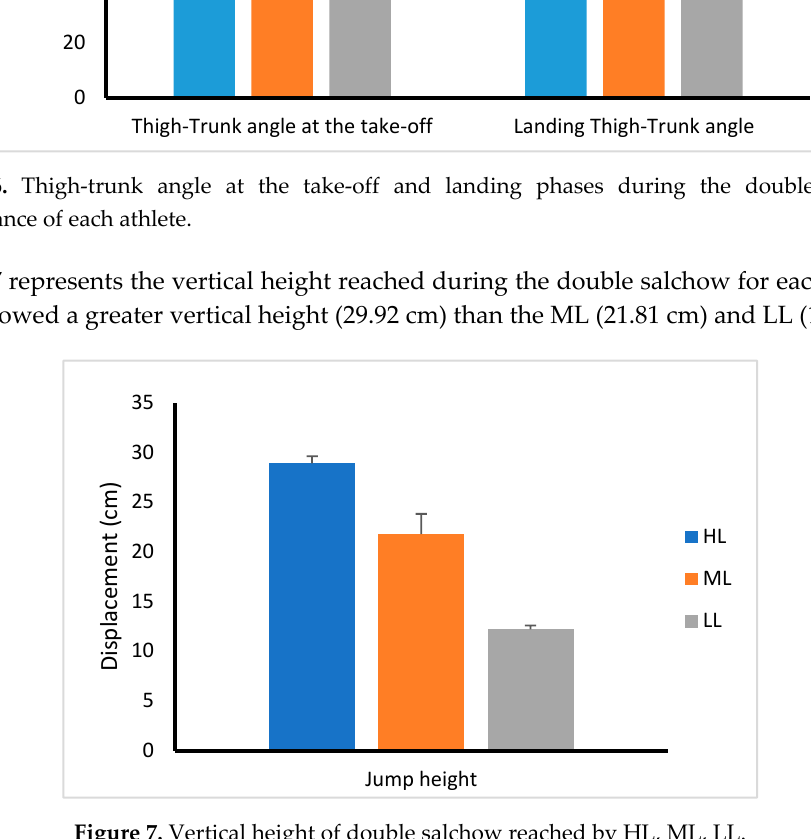
Figure 7. Vertical height of double salchow reached by HL, ML,